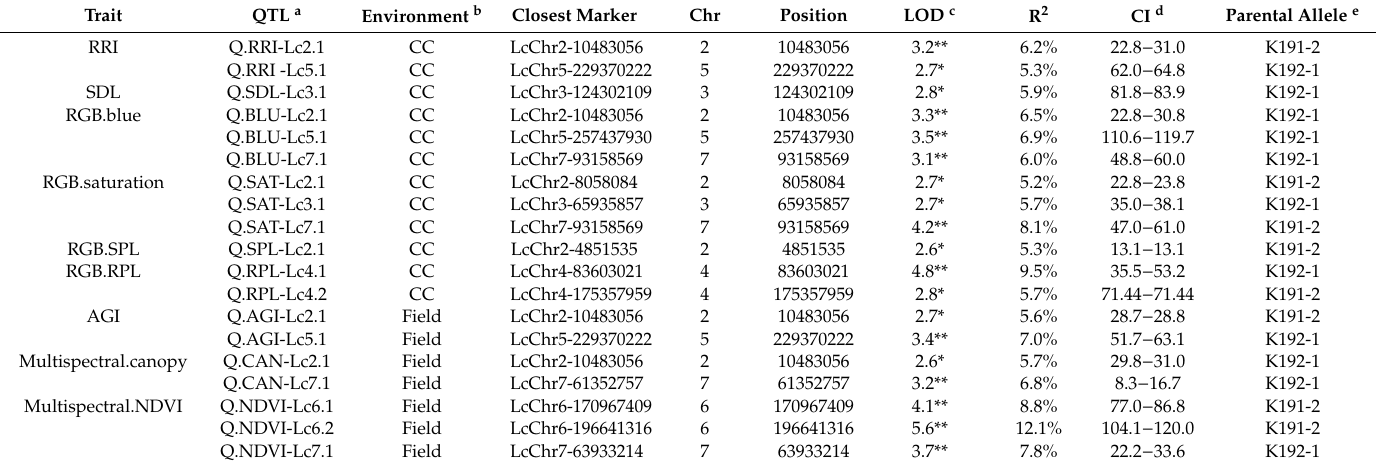
Table 2. Quantitative trait loci (QTL) for ARR resistance traits in the RIL population across two